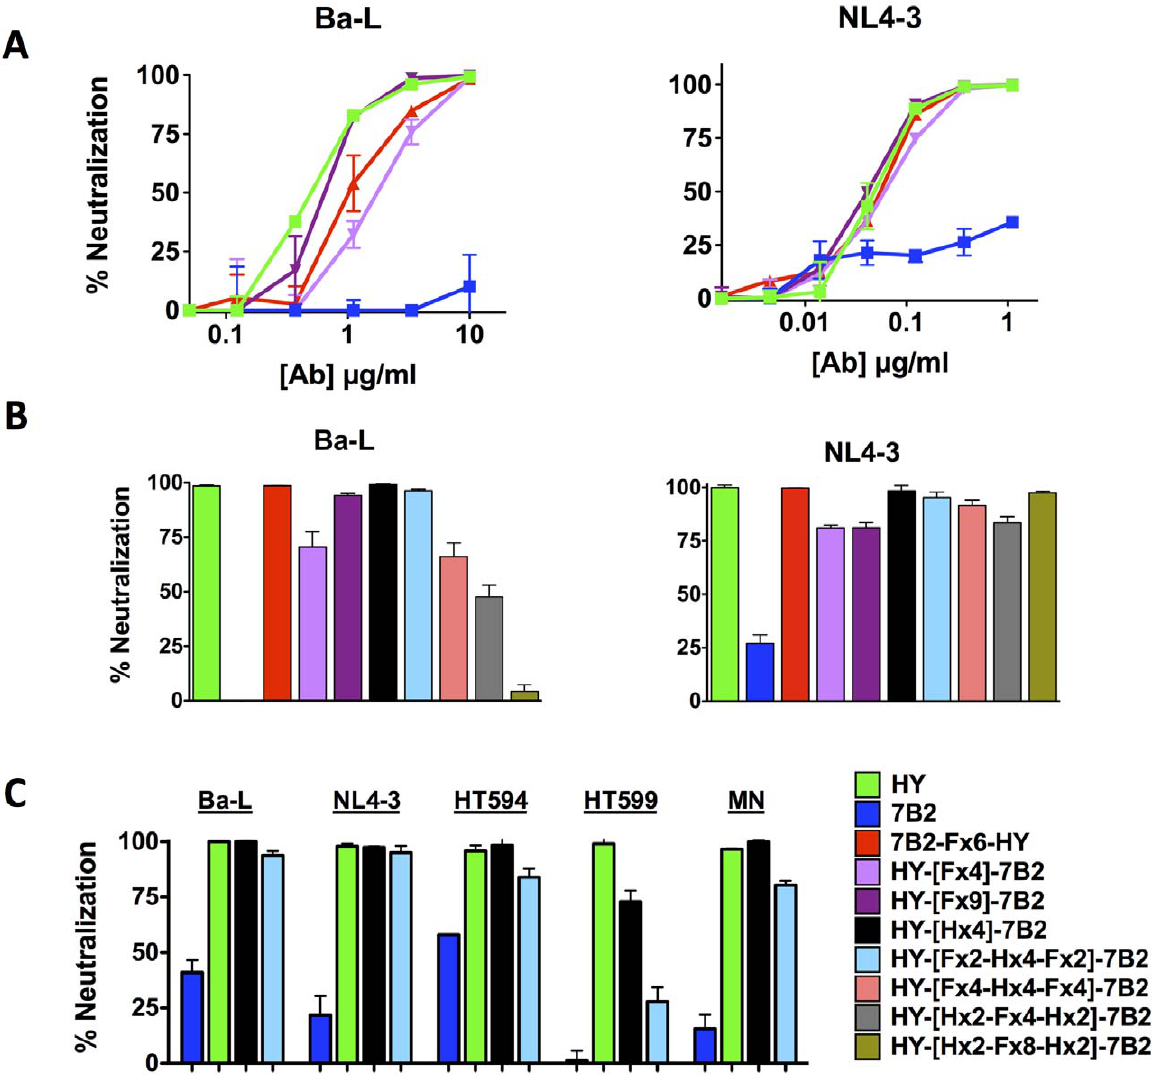
Figure 7. Neutralization of HIV infectivity by DVD-Igs. The ability of the DVD-Igs to neutralize different isolates of HIV was tested using the TZM-bl assay. A. Antibodies were titrated. B. and C. Antibodies were tested at 10 m g/ml, except against NL4-3 which was tested with 1 m g/ml. Ab and a predetermined dilution of virus were mixed and transferred to a monolayer of TZM-bl cells. Three days later, infectivity was read as chemiluminescence. Results are displayed as percent neutralization (virus/no Ab=0%; no virus=100% neutralization) according to the formula: [1- (RLU Ab -RLU bkgrd )/(RLU NoAb -RLU bkgrd )]*100.